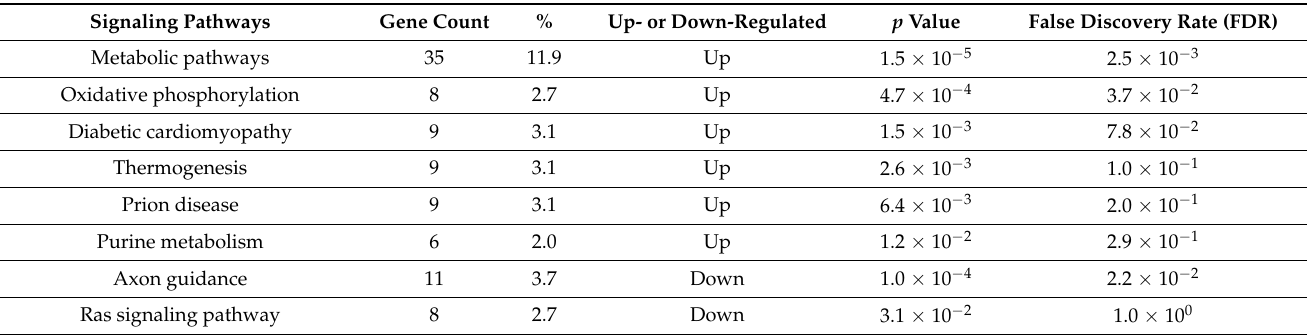
Table 3. Pathways of genes altered by TLR9 deficiency (vs. TLR9 sufficiency) in mouse lung macrophages treated with palmitic acid.